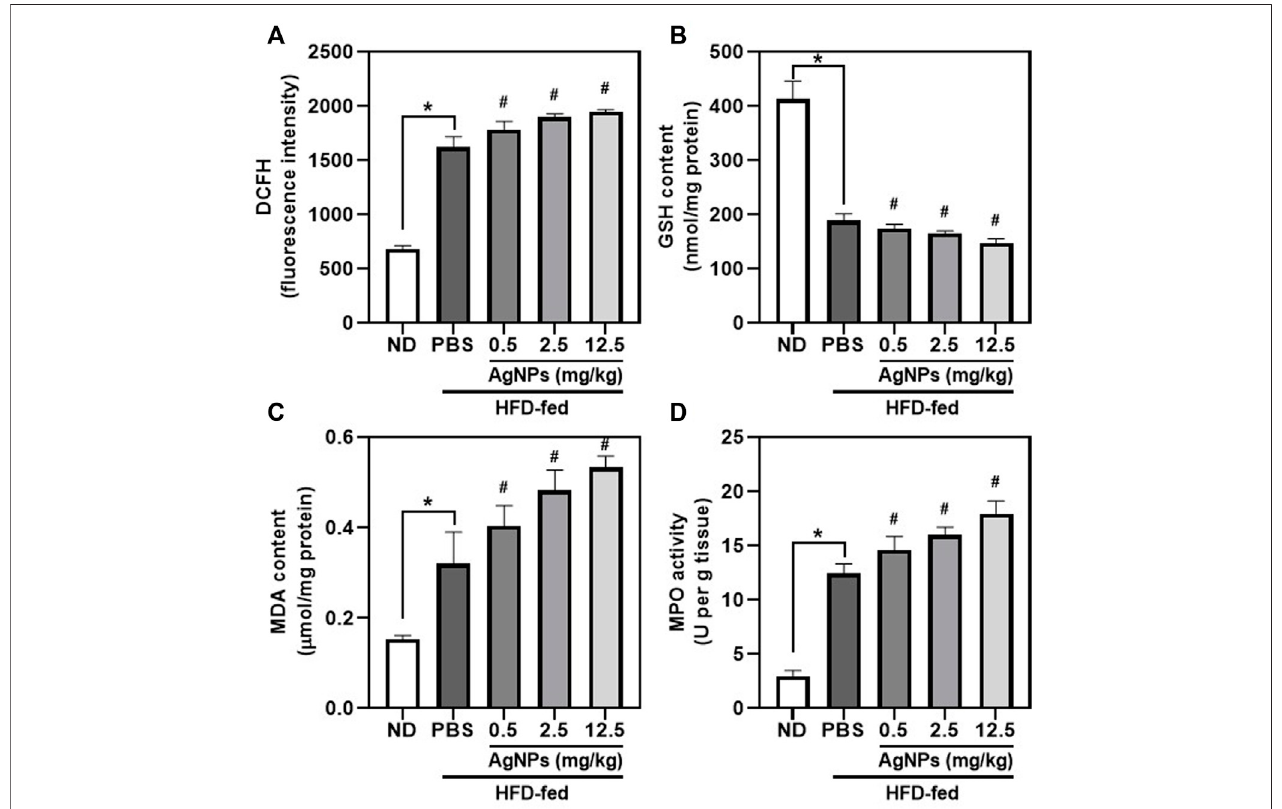
FIGURE 5 | AgNPs increased oxidative stress markers in the liver of NAFLD mice induced by HFD. Hepatic levels of ROS production (A) , GSH content (B) , MDA content (C) , and MPO (D) in ND- and HFD-fed micefollowing AgNP exposure for 1 w at the concentration of 0.5, 2.5, and 12.5 mg/kg * p < 0.05 vs. ND-fed group; # p < 0.05 vs. HFD-treated group.